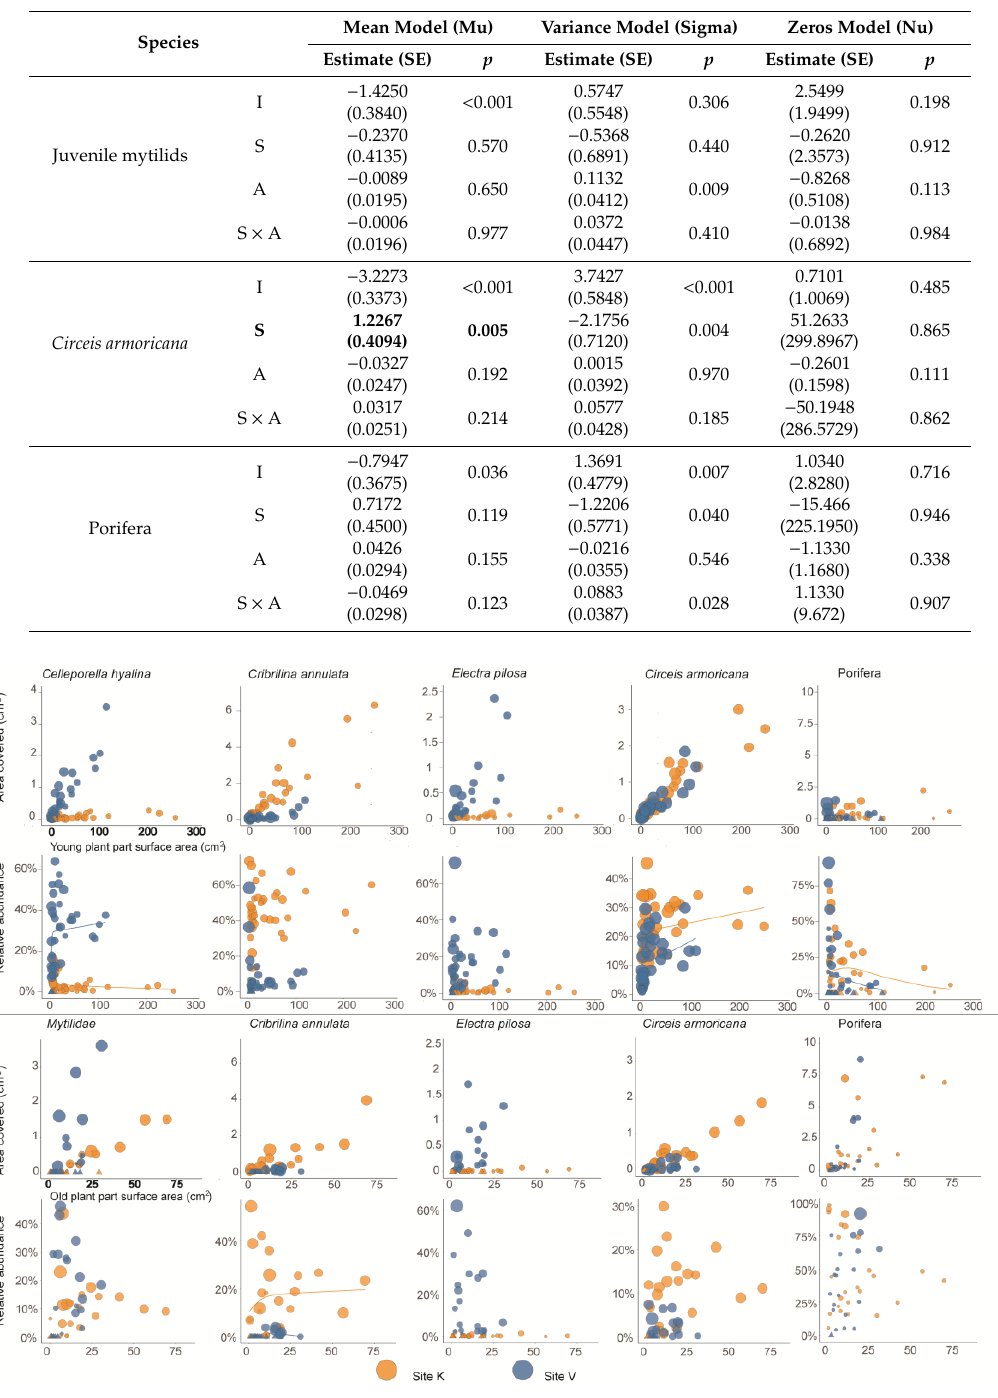
Table 8. Effects of plant part size (surface Area of the corresponding part, cm 2 ) and location (Sites K or V) on relative abundances of 5 top abundant species on young and old plant parts of Phycodrys rubens in September 2015: zero-inflated (logit link) beta-regression, mean (logit link) and variance (log link) modeled, frames pooled. I – intercept, Sources of variation: S – Site (K), A – plant part surface area. The model did not converge for E. pilosa on old blades since all the zero observations were at Site K, thus two separate models for the two sites were fitted. Significant terms in mean and zero models highlighted in bold.